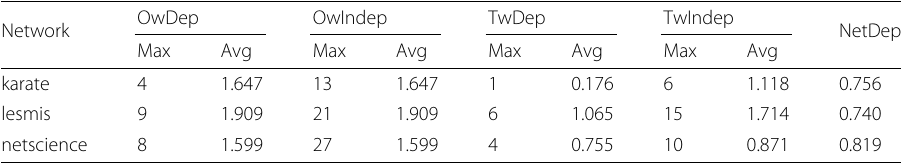
Table 2 Node dependencies and network dependency in small